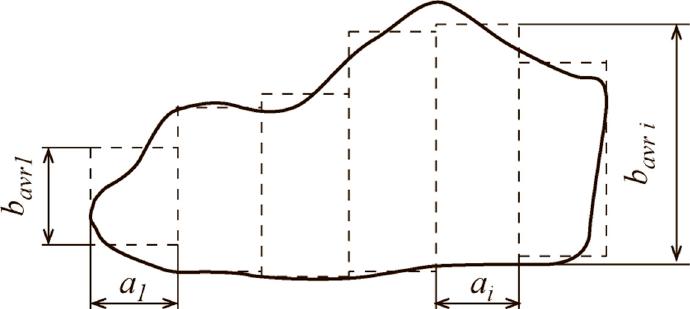
Figure 7. Calculation of defect zone area of a complex shape.